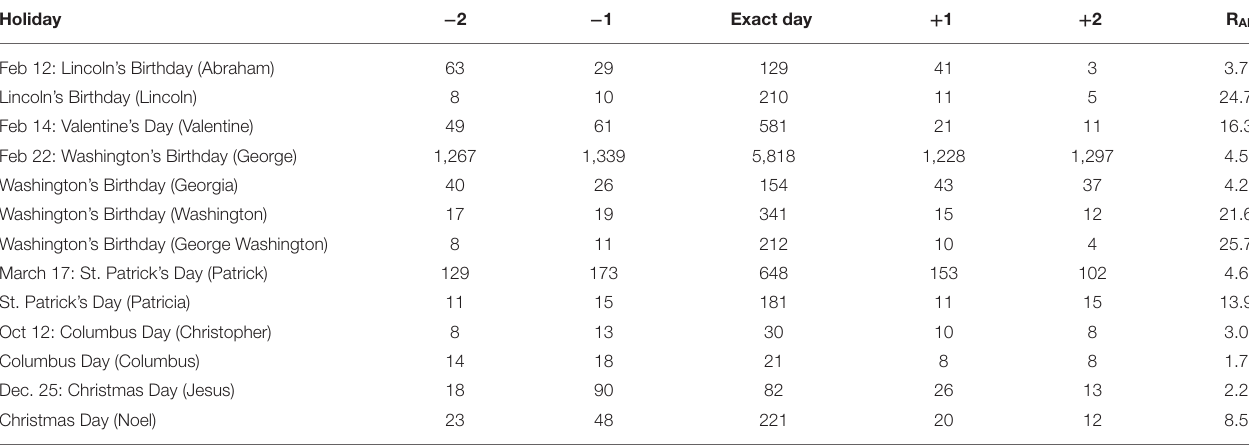
TABLE 2 | Likelihood of being named after a famous person as a function of (presumably) being born on a holiday honoring the famous person.